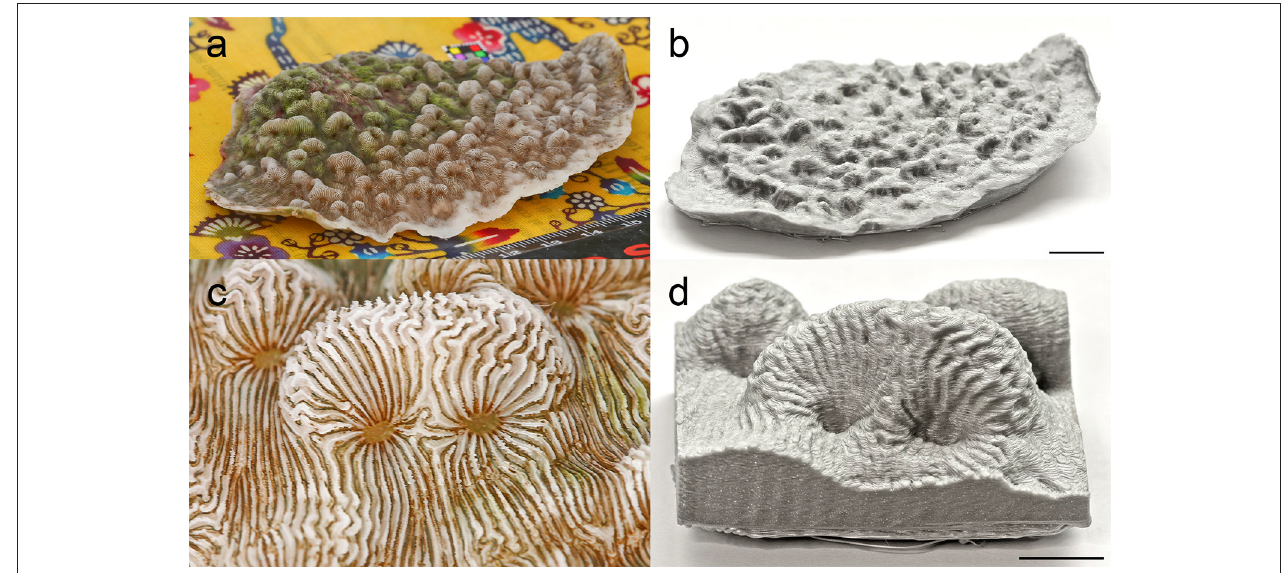
FIGURE 4 | Multi-scale 3D printing of Leptoseris incrustans colony and corallites. (a) Image used in 3D digitisation of colony sample. (b) Silver PLA print of colony sample. (c) Image used for 3D digitisation of corallites. (d) Silver PLA print of corallites. Scale bar represents 1cm.